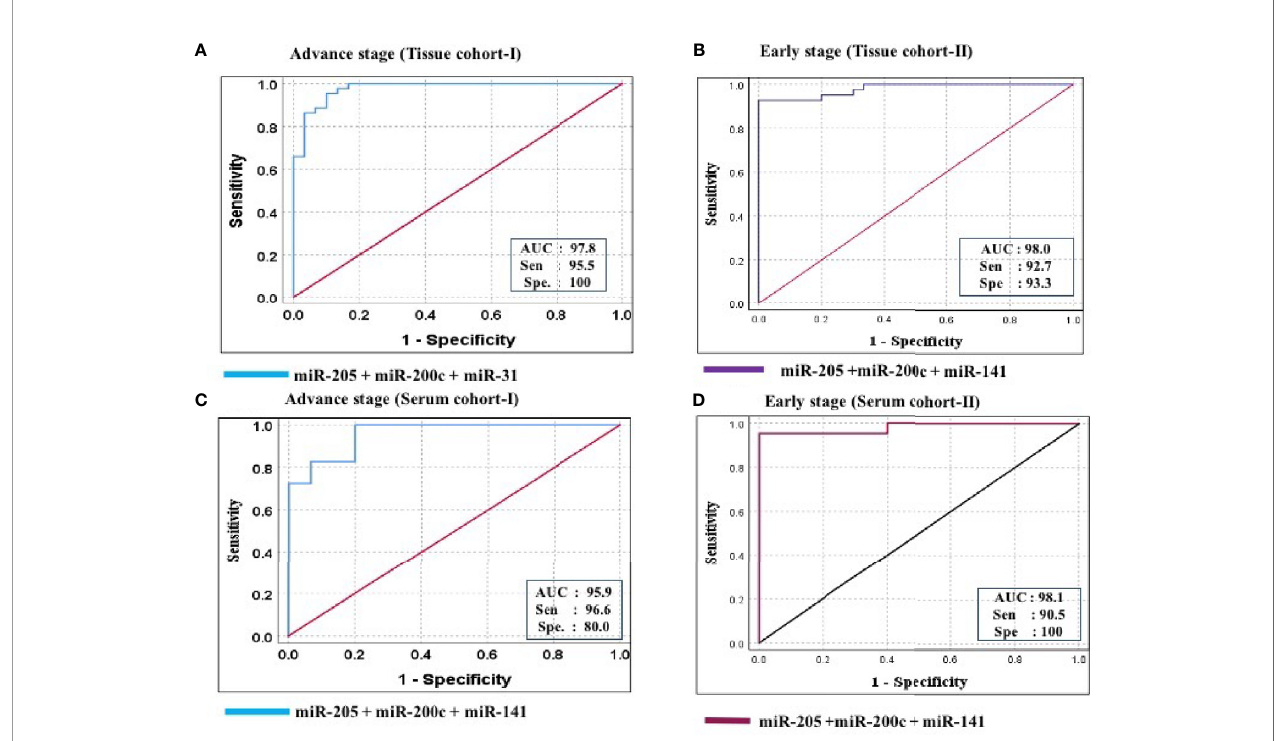
FIGURE 7 | ROC curve analysis in tissue and serum cohort to evaluate the ability of the combined miRNA panel (miR-205 + miR-200c + miR-141) to diagnose ovarian cancer. (A) In tissue cohort-I ( n = 74), the combined measure of sensitivity and speci fi city of miR-205 + miR-200c + miR-141 was represented by AUC at 95% CI, p -value = 97.8 (0.950 – 1.006, p < 0.0001). (B) In tissue cohort-II ( n = 71), the AUC of miR-205 + miR-200c + miR-141 at 95% CI, p -value = 98.0 (0.954 – 1.006, p < 0.0001). (C) In serum cohort-I ( n = 45), the combined measure of sensitivity and speci fi city of miR-205 + miR-200c + miR-141 was represented by AUC at 95% CI, p -value = 95.9 (0.925 – 1.012, p < 0.0001) (D) In serum cohort-II ( n = 35), the AUC of miR-205 + miR-200c + miR-141 at 95% CI, p -value = 95.2 (0.941 – 1.021, p < 0.0001). Predicted probability, miR-205 + miR-200c + miR-141; AUC, area under the curve; Sen, sensitivity; Sep, speci fi city.